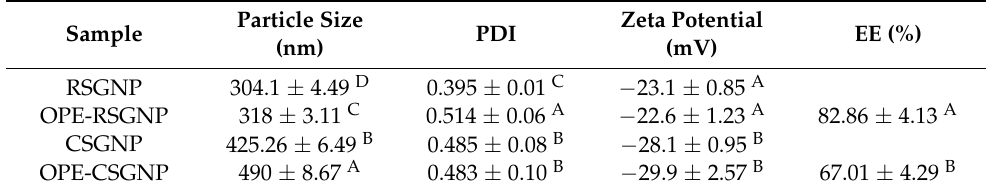
Table 3. Particle size, zeta potential and encapsulation efficiency of nanoparticle suspensions. Particle Sample